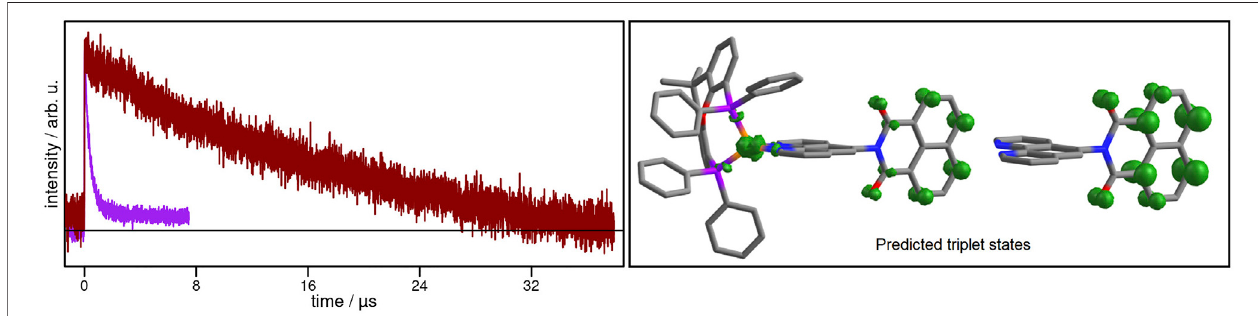
FIGURE4| Left:Transientabsorptionspectraof CuNIphen at480 nminMeCN(darkred)andinCH 2 Cl 2 (purple)solutionunderinertconditionsexcitedat355 nm. Right: Calculated spin density of the optimized lowest triplet state of CuNIphen simulated in CH 2 Cl 2 (B3LYP-D3(BJ)/def2-tzvp, CPCM, isosurface value: 0.01). Please note that the identical calculation simulating MeCN (CPCM) yielded similar results ( Supplementary Figure S35